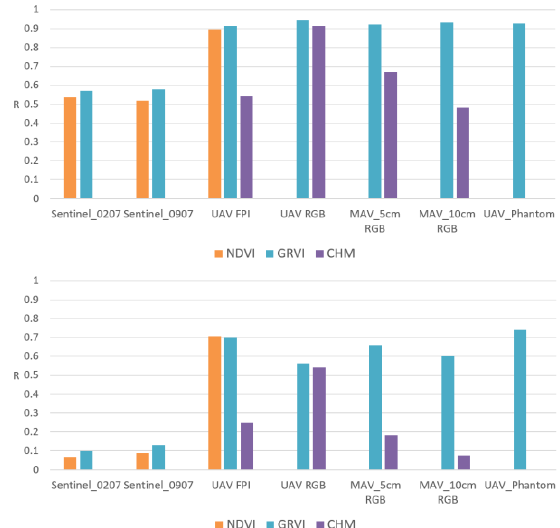
Figure 4. Correlations (R) from the linear regression of the dry biomass (top) and nitrogen (bottom) and the remote sensing NDVI, GRVI and CHM features from different data sets.